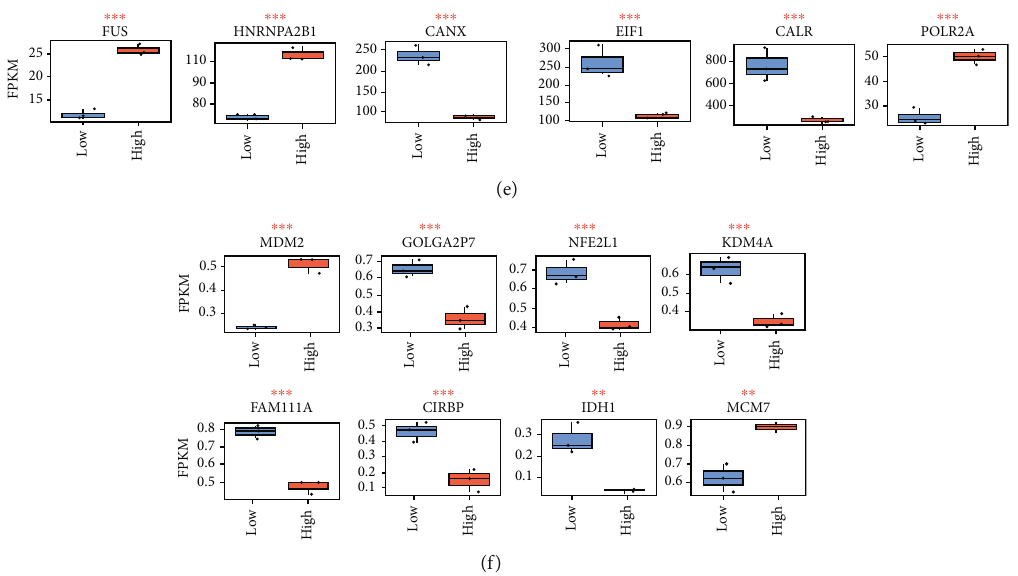
Figure 3: Network between di ff erential RNA-binding proteins (RBPs) and regulated alternative splicing genes (RASGs) in hypoglycemia and hyperglycemia samples. (a) Venn diagram showing di ff erentially expressed RNA-binding protein genes; p value = 1. (b) Coexpression analysis was carried out according to overlap gene and RAS of non-intron retention (NIR), and then, 80% of samples were screened for the Parameter: value ≤ 0.01. (c) The GO analysis of RASGs regulated by RBPs. (d) The coderegulation of alternative splicing network between RBPs (the leftmost part) and RASEs (the middle left part, which only includes NIR RASEs). The top enriched GO terms of codisturbed RASGs (the middle right part) were shown in brown (the rightmost part). (e) The boxplot showing the RBPs marked in (d). (f) The boxplot showing the RASGs. ∗∗∗ p < 0 : 001 and ∗∗ p < 0 : 01 .